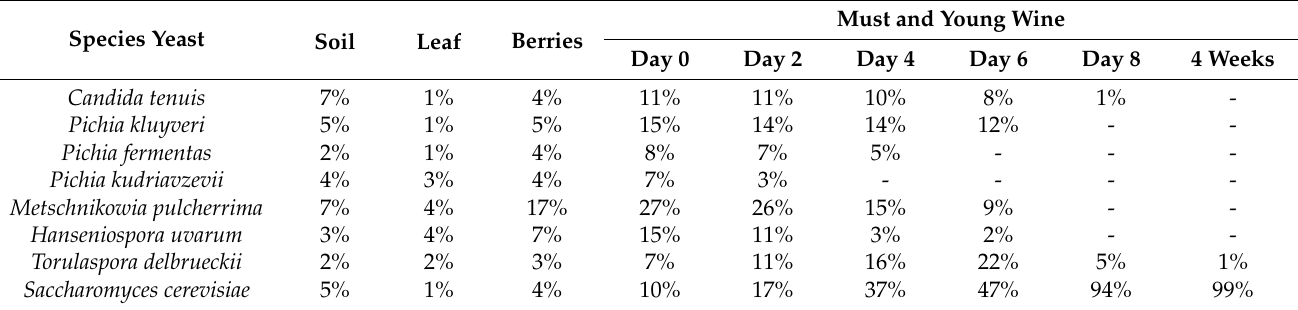
Table 5. Percentages of individual yeast